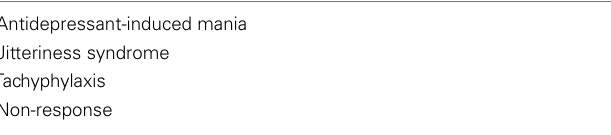
Table 1 | Failure of the “SSRI challenge” test-clinical features